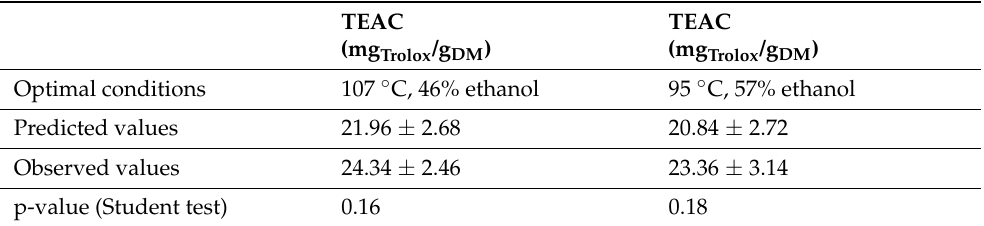
Table 7. Comparison between predicted and experimental values for